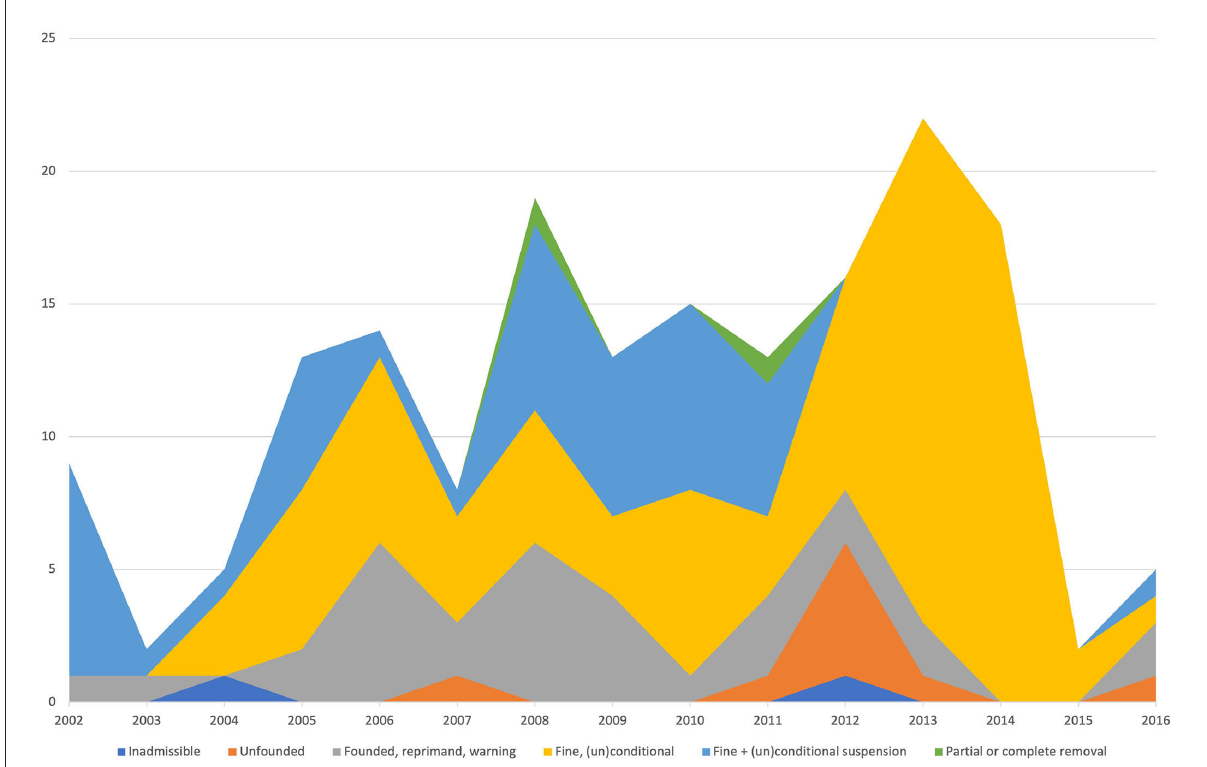
FIGURE2 Rulings of the VDC for only cases filed by the civil servant (CS) from 2002 to 2016. The color corresponds with the ruling of the